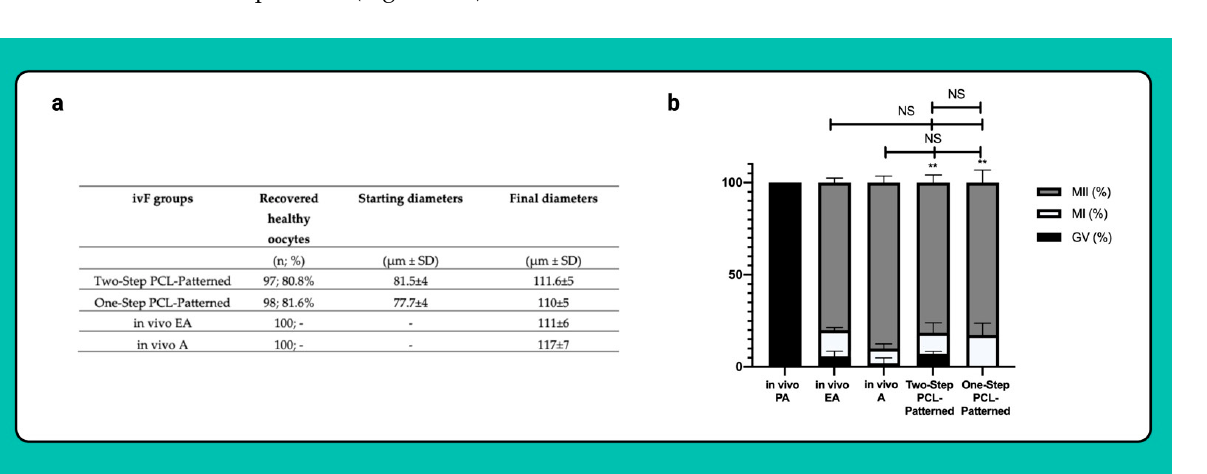
Figure 13. ( a ) Table summarizing the number of recovered healthy oocytes and their mean diame- ters at the end of ivF culture. A total of 120 and 120 follicles were cultured in three independent experiments during which Two-Step PCL-Patterned and One-step PCL-Patterned electrospun scaf- folds were simultaneal compared (Two-Step PCL-Patterned: 40, 40, and 40 PA follicles per experi- ment; One-Step PCL-Patterned: 40, 40, and 40 PA follicles per experiment). For each ivF group (Two- Step PCL-Patterned and One-Step PCL-Patterned), 97 and 98 healthy oocytes were recovered and analyzed at the end of the in vitro culture to test the oocyte performance. Only the oocytes retrieved from follicles that differentiated the follicular antrum, were tested; data are expressed as mean ± SD. ( b ) Percentage of the oocyte meiotic competence acquired in vitro. Different nuclear stages were characterized. **: statistically significant vs. in vivo PA follicles group ( p < 0.05). NS: not statistically significant. Data in which subscripts are not indicated, were considered not significant. GV: Germi- nal Vesicle; MI: Metaphase I; MII: Metaphase II.